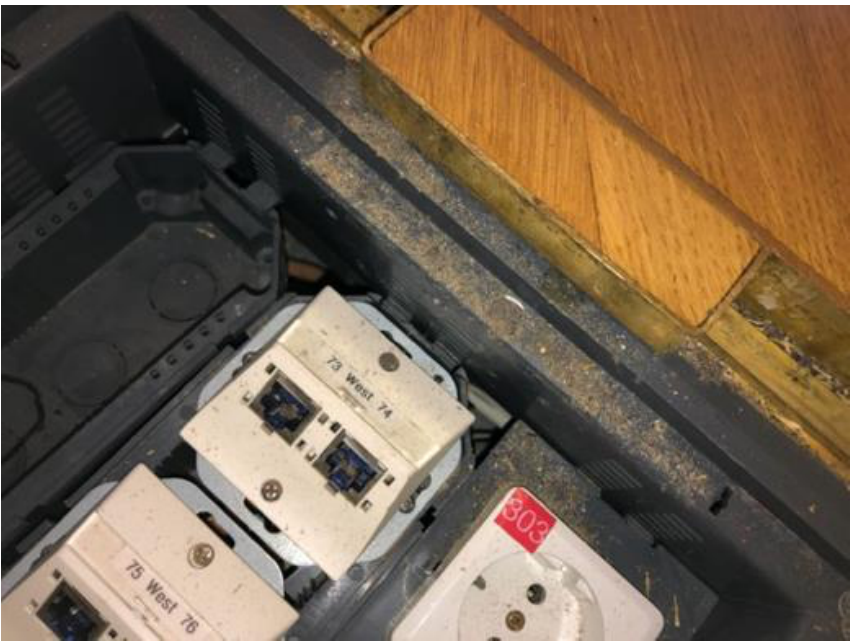
Figure 9. Microhabitat 2 of Ctenolepisma calvum (in the center of the photograph) in an electric socket in a museum in Vienna as part of a wooden parquet floor.